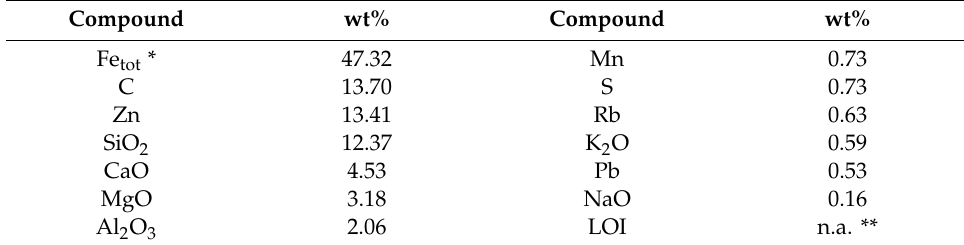
Table 1. Chemical composition of reference sample (C / O =